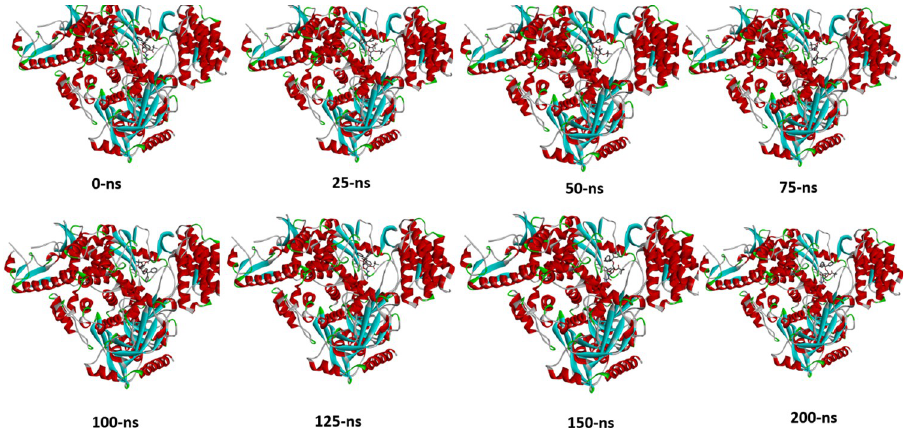
Fig 8. Molecular dynamic simulation. Snapshots of compound 13 with the enzyme at different